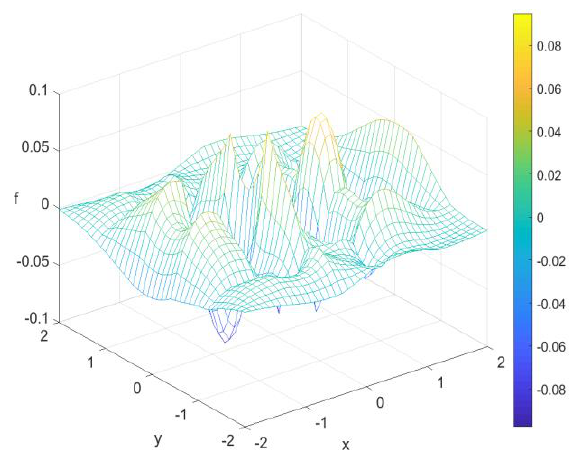
Figure 10. Error in fitting linear least squares B-spline